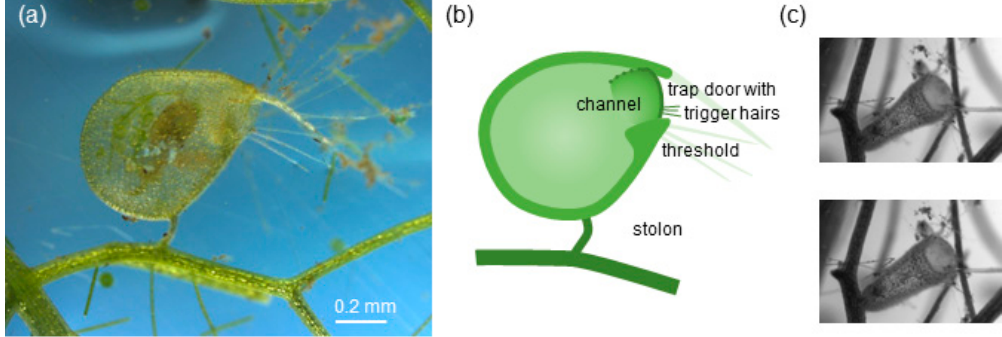
Figure 1. Trap of aquatic bladderwort Utricularia sp. of the vulgaris trap type [32]. ( a ) Lateral view of a single vulgaris -type trap; the trap contains a prey item (ostracod). ( b ) Sketch of a vulgaris -type trap; the trap mouth is surrounded by long bristles (light green) and is closed off by a dome-shaped trap door (dark green line) with trigger hairs (fine dark green lines); as the door opens inward (dotted green line), it forms a channel between the door and the threshold. ( c ) Frontal view of a vulgaris -type trap, before (top panel: loaded trap) and after triggering (bottom panel: unloaded trap).